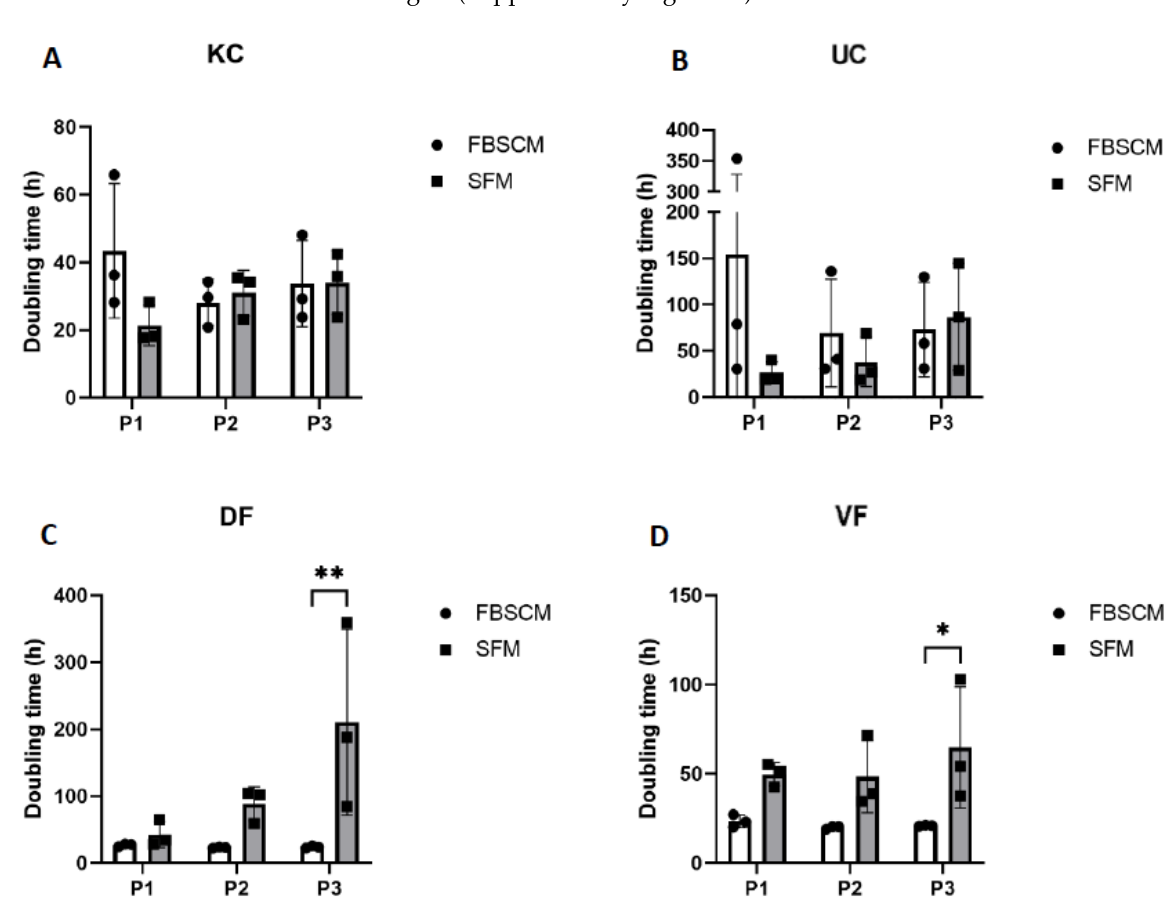
Figure 3. Doubling time of keratinocytes (KC, panel ( A )), urothelial cells (UC, panel ( B )), dermal fibroblasts (DF, panel ( C )) and vesical fibroblasts (VF, panel ( D )) over three passages. Ordinary two-way ANOVA was used to interpret the data. Asterisks indicate significant differences: (*) for p -value < 0.05, (**) for p -value < 0.01. Each dot represents the mean (N = 3) of a cell population cultured in triplicate ( n = 3).